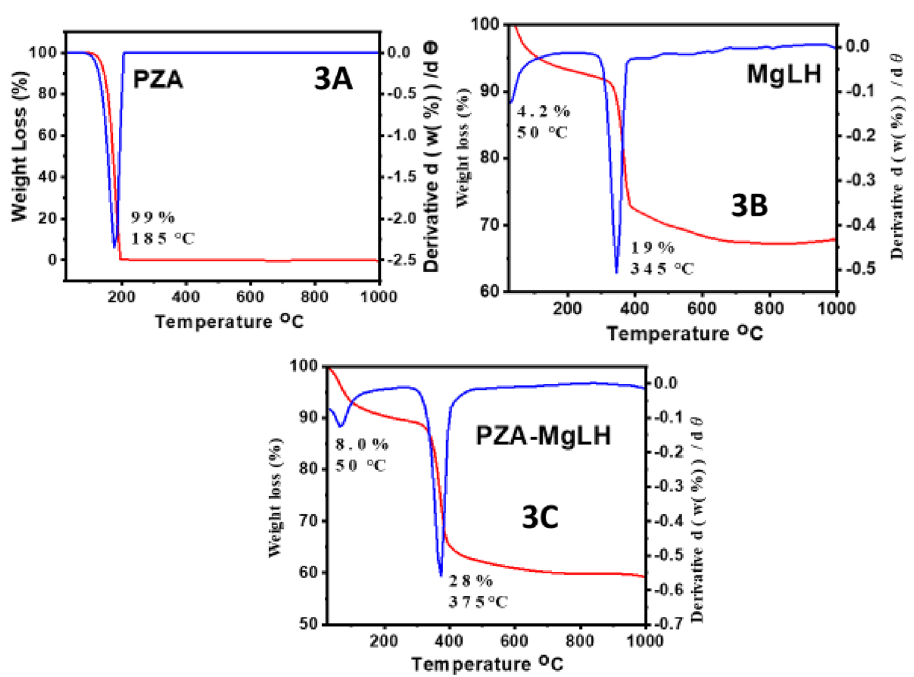
Figure 3. TGA/DTG thermograms of the free drug, PZA ( A ), MgLH ( B ) and PZA-MgLH ( C